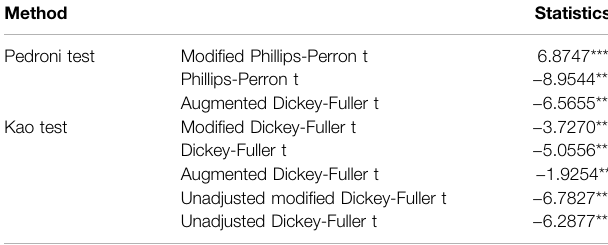
TABLE 3 | Results of panel co-integration test Method